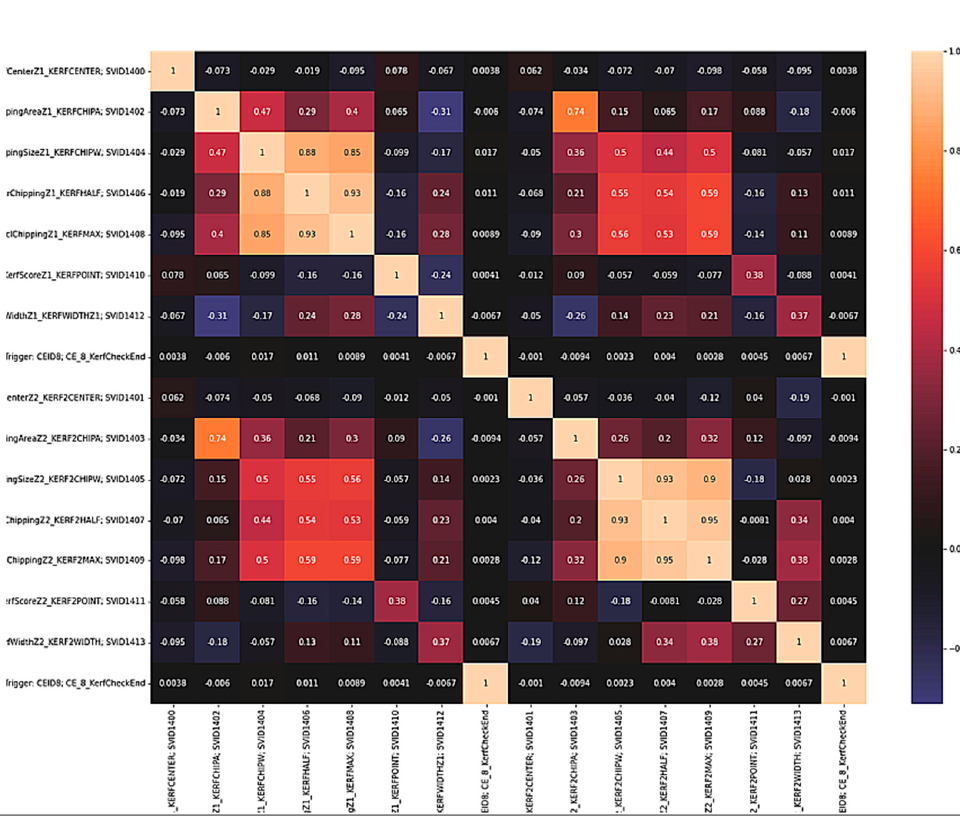
Figure 16. Correlation coefficient